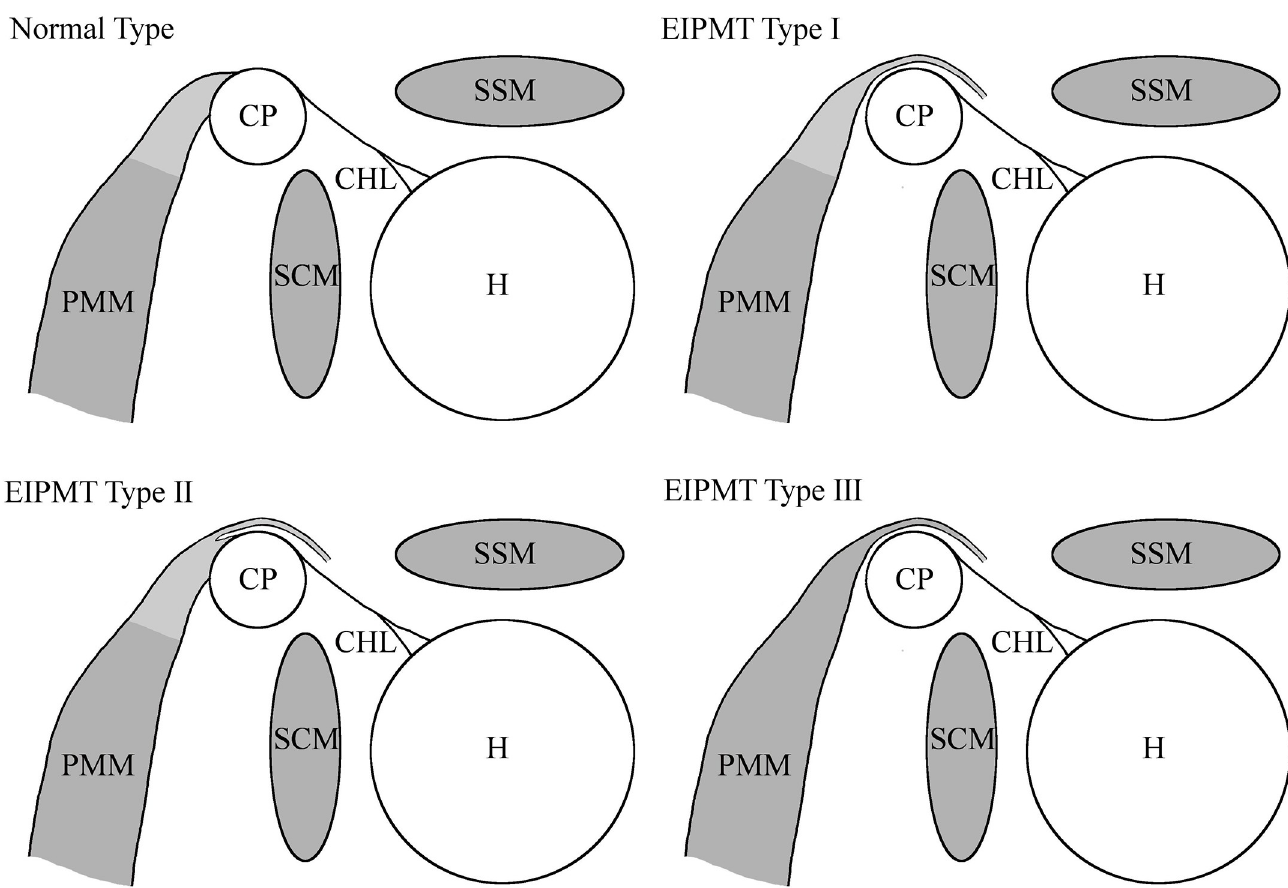
Fig 1. Schematic sagittal section of shoulders showing different kinds of EIPMTs according to Le Double. Modified from Lee 2014 [4]. CHL = coracohumeral ligament, CP = coracoid process, H = humerus, PMM = pectoralis minor muscle, SCM = subscapularis muscle, SSM = supraspinatus muscle. https://doi.org/10.1371/journal.pone.0218715.g001 PLOS ONE | https://doi.org/10.1371/journal.pone.0218715 June 21,